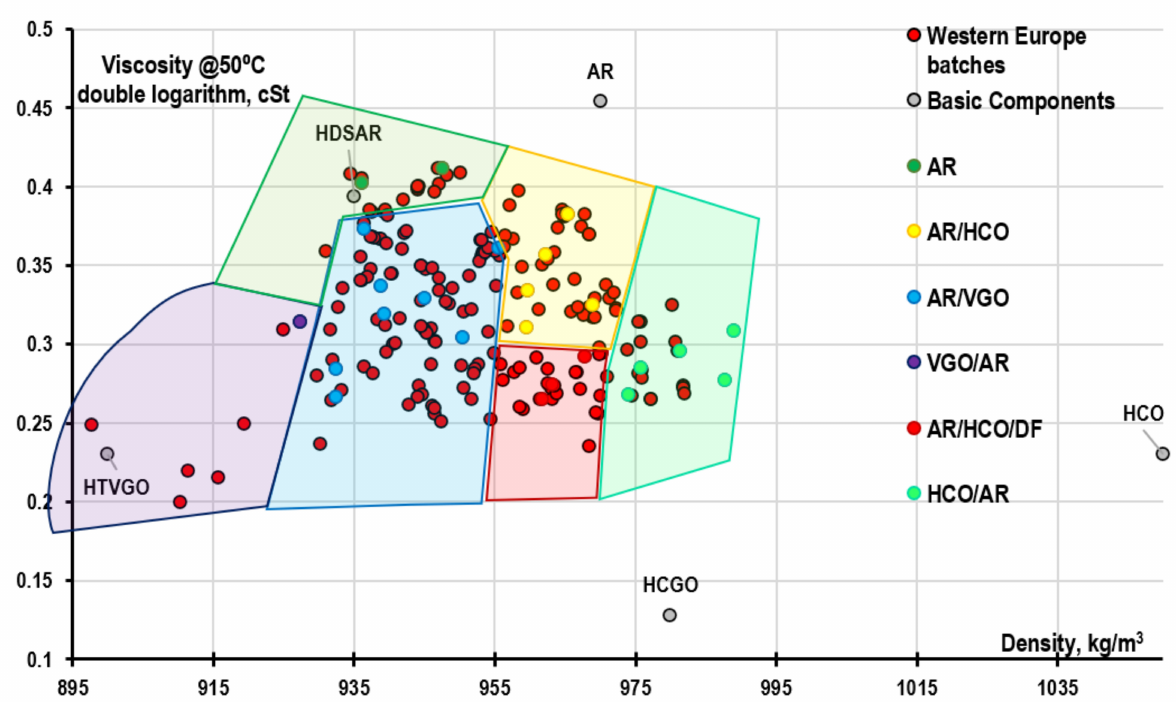
Figure 23. Division of all studied shipments of Western European ports by type